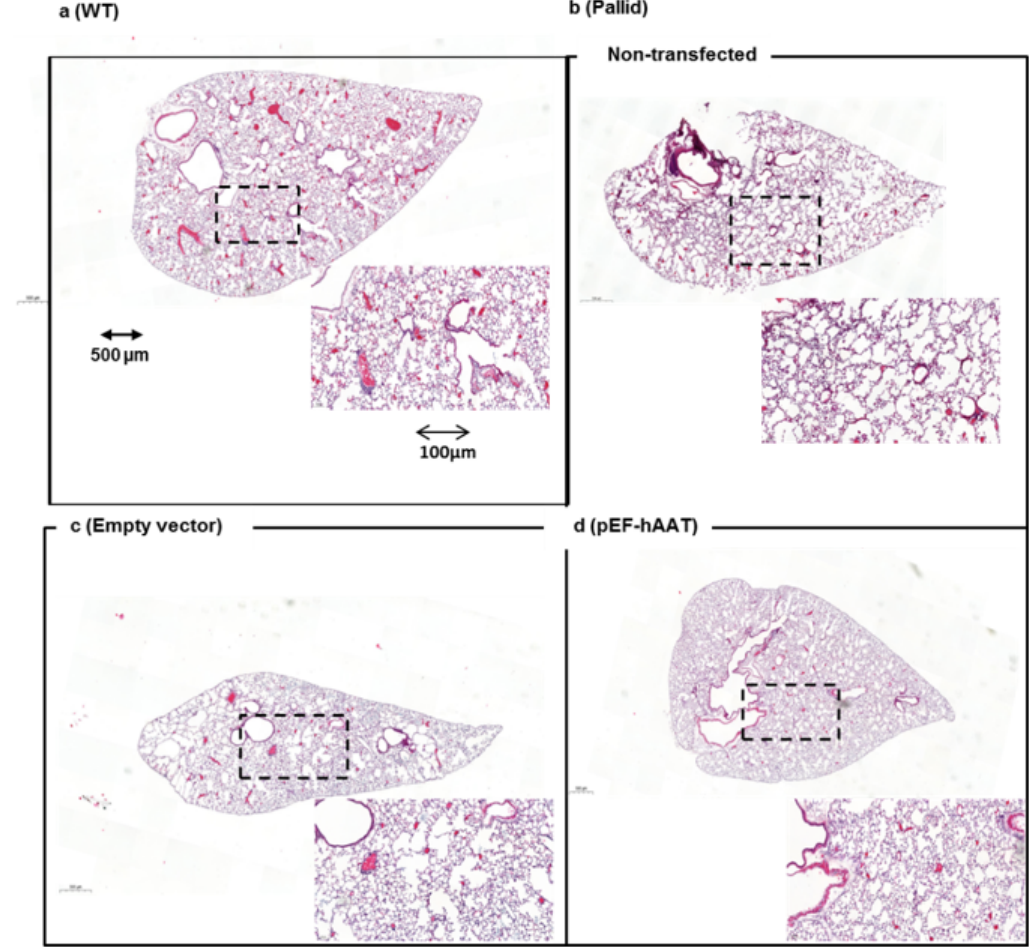
Figure 3. Left lobe lung histology after intrahepatic AAT gene transfer by electroporation in vivo: